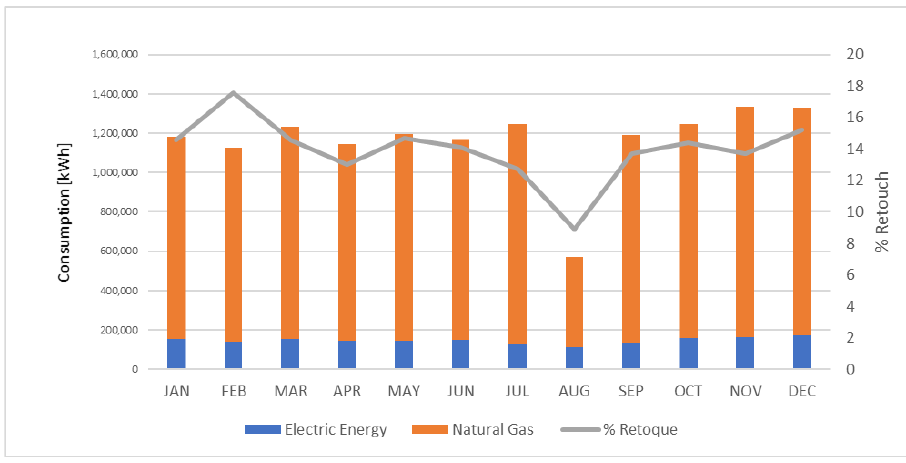
Figure 1. Energy consumption and % in retouch in 2021. From the beginning of 2021 until the end of November, this unit had 14.21% of retouched parts, which is higher than the defined objective of 12%. Thus, it became important to analyze the most frequent defects during this period to understand their causes. To this end, the available data over this period was used to characterize the initial